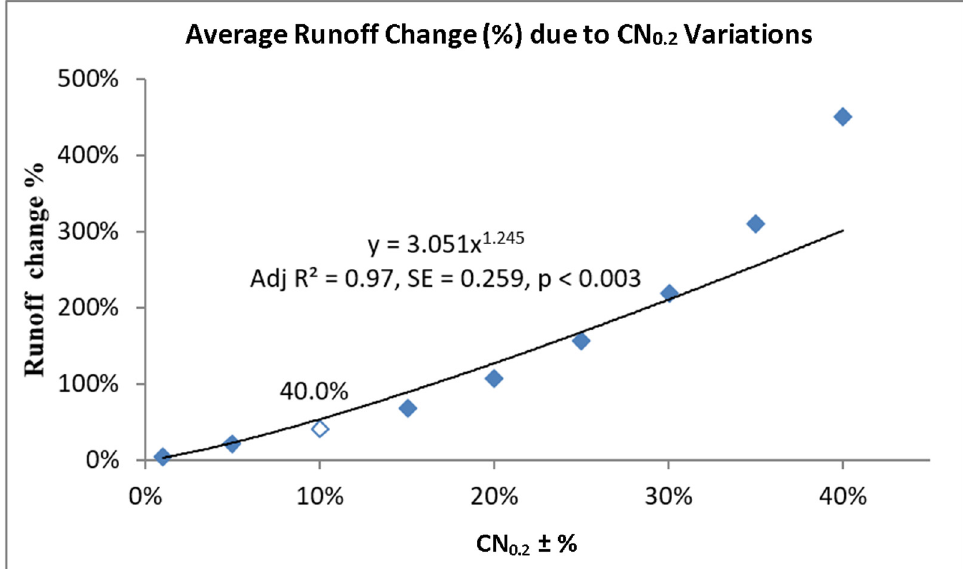
Figure 7. Response of runoff change to variation of CN 0.2 . Runoff change % data points are the averaged runoff change due to CN 0.2 upscaling and downscaling of a specific variation %. The blank data point shows the average runoff change % due to CN 0.2 ± 10% variation.